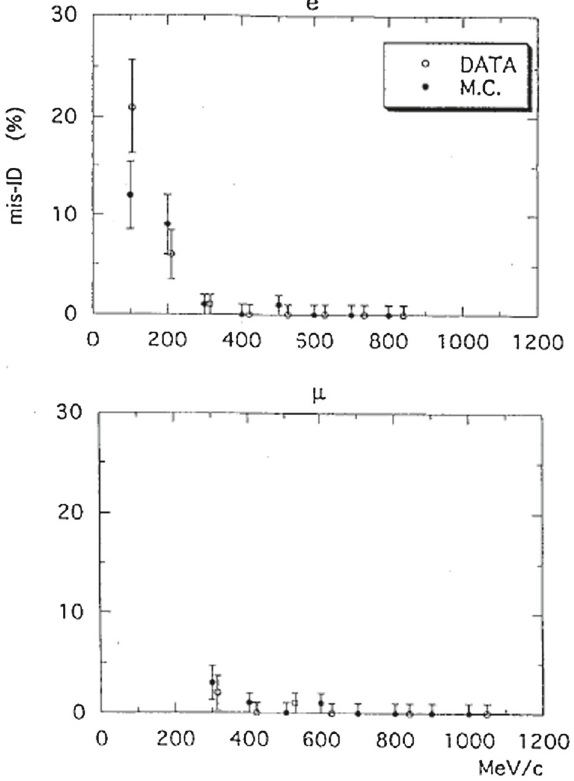
Fig. 5 The misidentification probabilities for e → μ (top) and μ → e (bottom)